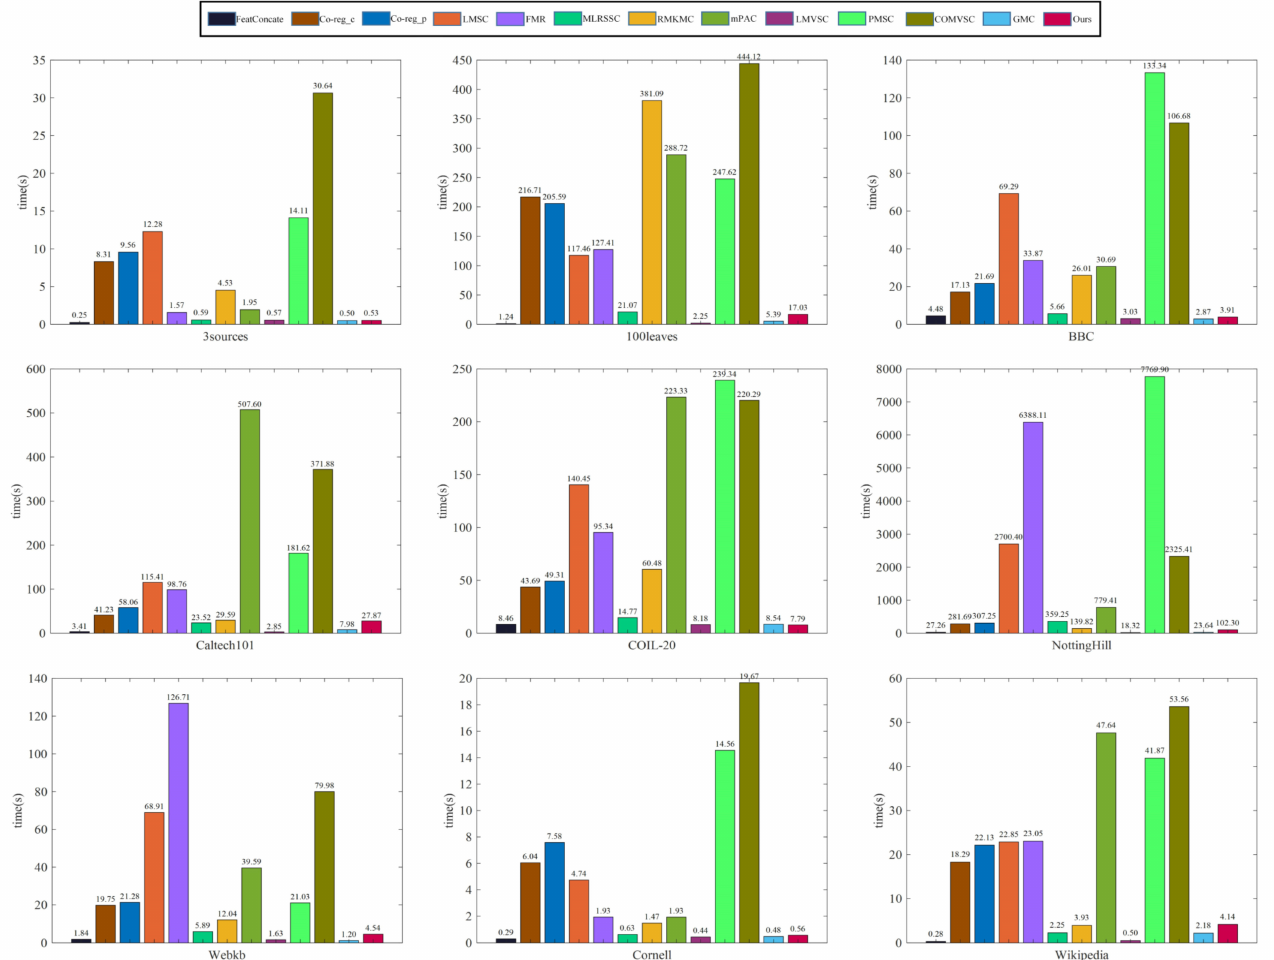
Figure 3. Running time of different methods on nine multi-view data